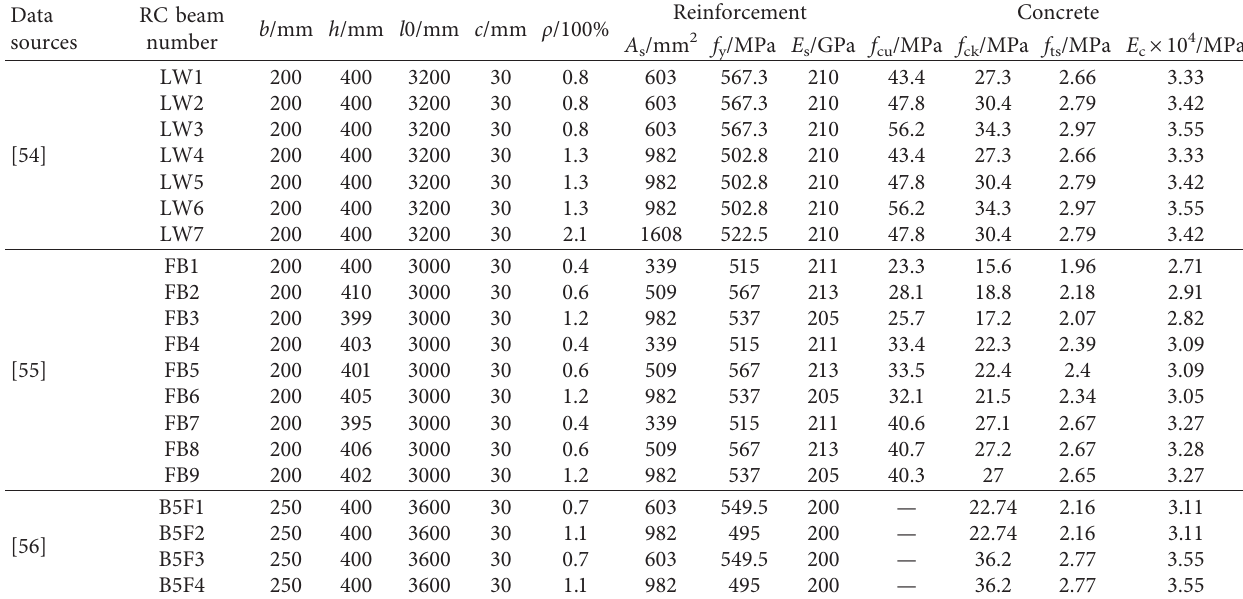
Figure 6: Comparison of experimental flexural bearing capacity M u with M uc calculated by different codes for beams with 400MPa steel bars. Table 8: Details of beams with 500MPa steel